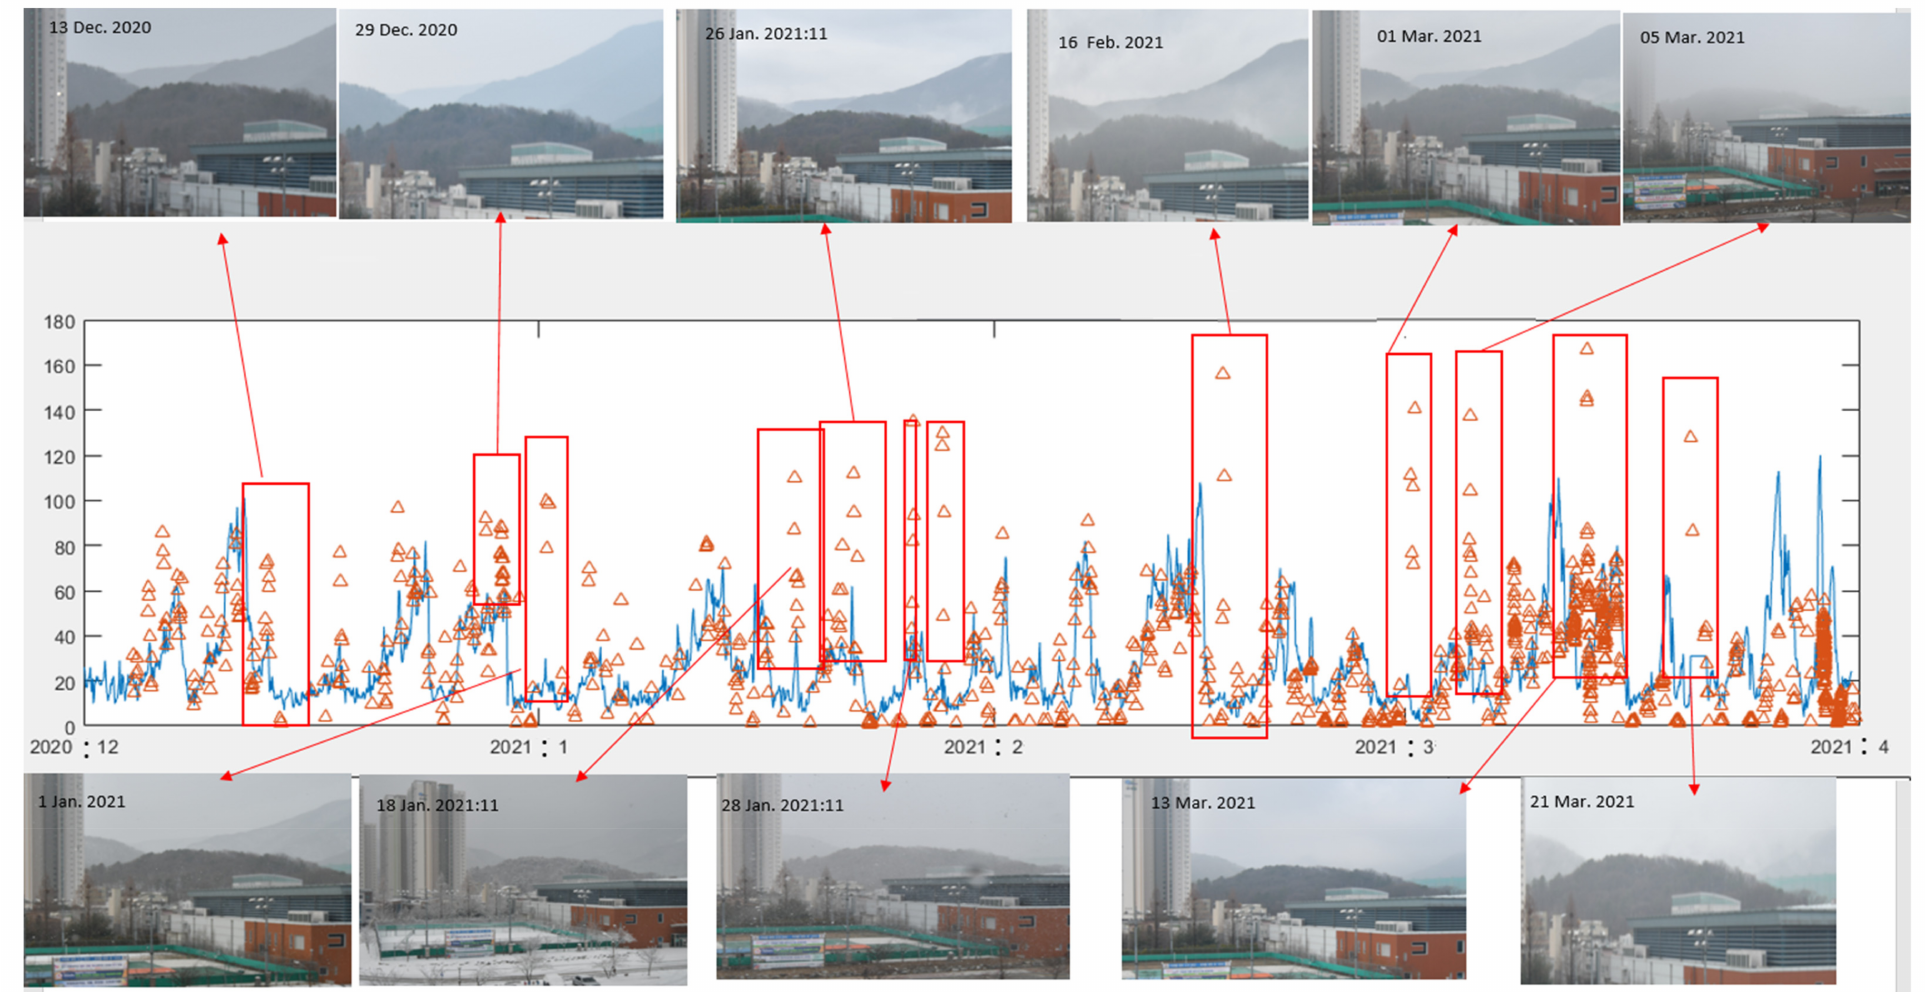
Figure 14. Comparison of the extinction coefficients (blue) measured for four months (from December 2020 to March 2021) and PM 2.5 values obtained via the domestic environmental measurement network. Photos are shown for the dates characterized by a significant difference between the two